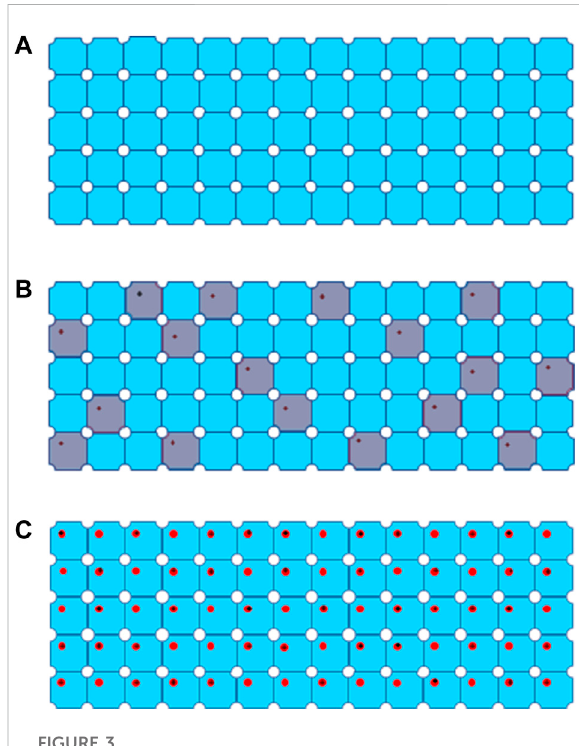
FIGURE 3 Process of global damage to a 3D protein crystal from (A) a well-ordered crystal without radiation damage, (B) global damage afterextremelylowdoseirradiation,defectedunitcellsarecolored in grey, to (C) global damage with progressively high dose marked by black cross for site speci fi c damage